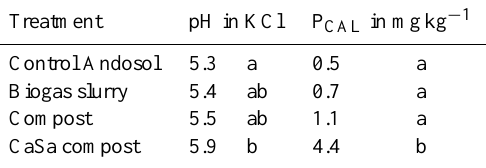
Table 4. Chemical analysis of the untreated Andosol in Karagwe, Tanzania, and the amended topsoil (0–30cm) horizons sampled at the end of the